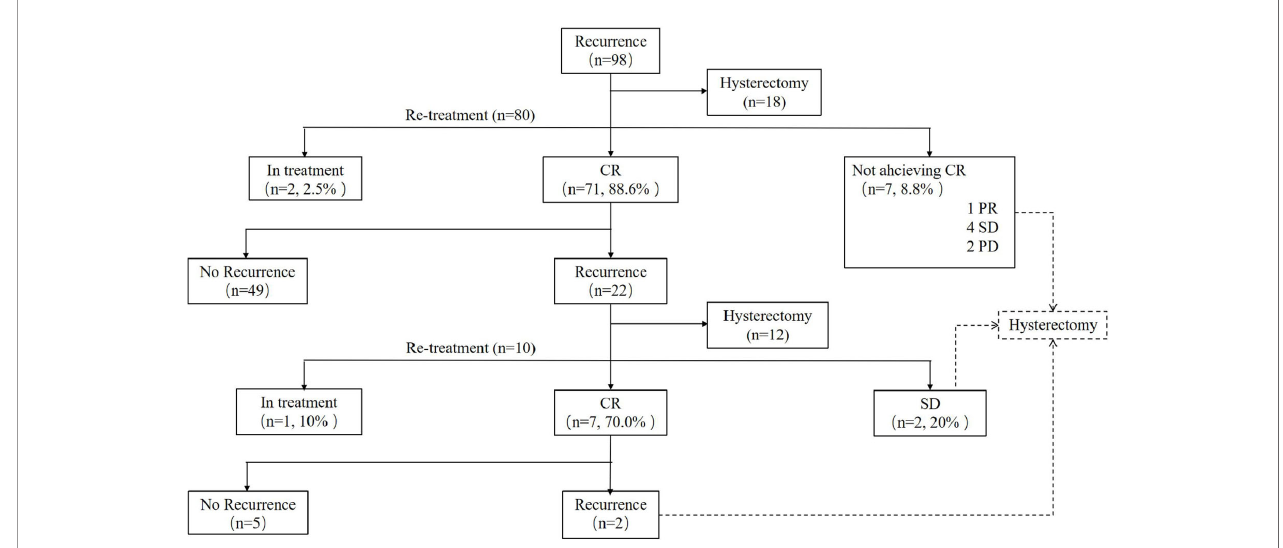
FIGURE 1 | Outcomes of patients who received re-treatment. CR, complete response; PR, partial response; SD, stable disease; PD, progressive disease.